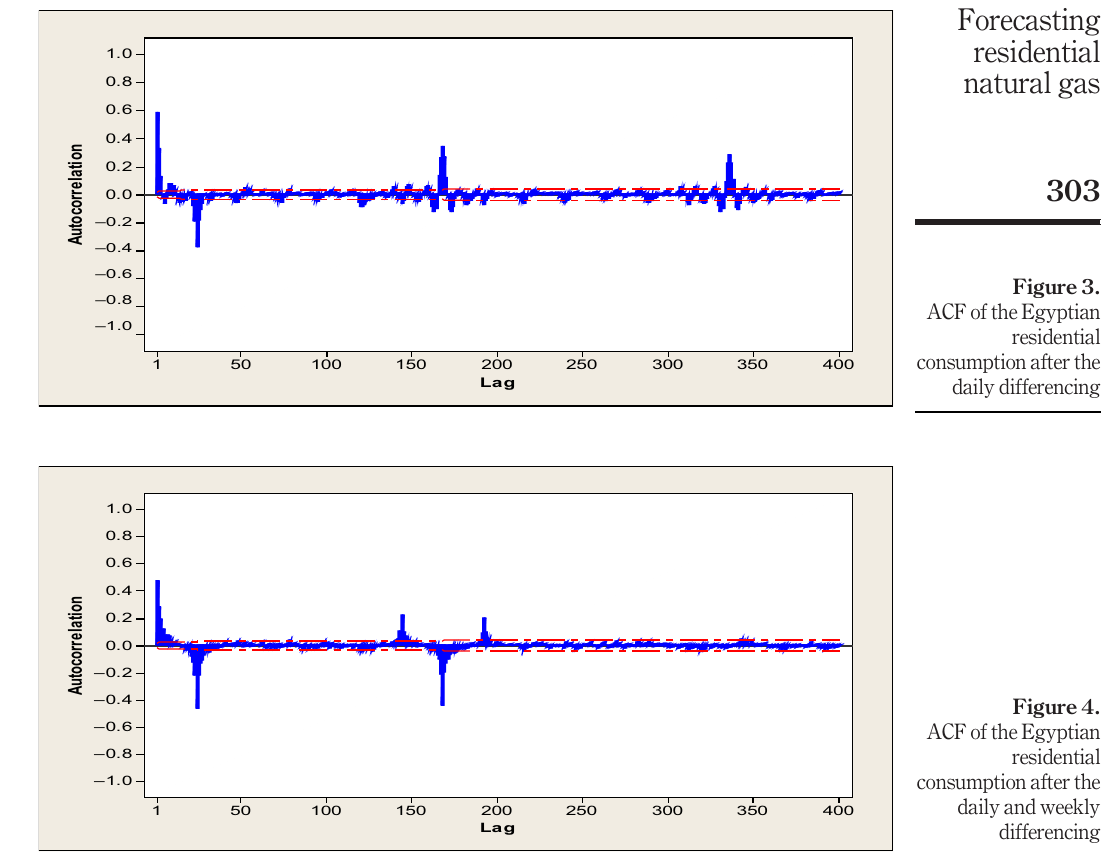
ACF of the Egyptian consumption after the daily and weekly